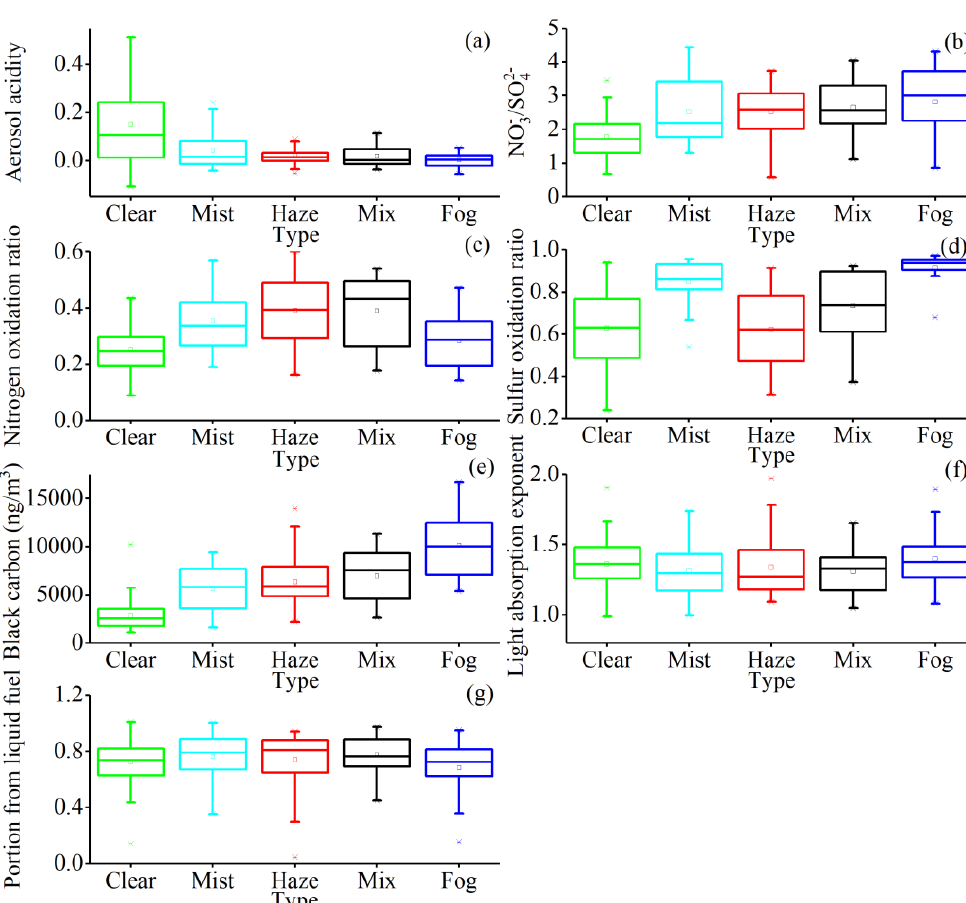
Figure 7. The value of ( a ) aerosol acidity, ( b ) NO 3− /SO 42− , ( c ) nitrogen oxidation ratio, ( d ) sulfur oxidation ratio, ( e ) black carbon mass concentration, ( f ) light absorption exponent, and ( g ) the portion of the BC contribution from the liquid fuel sources in different process.